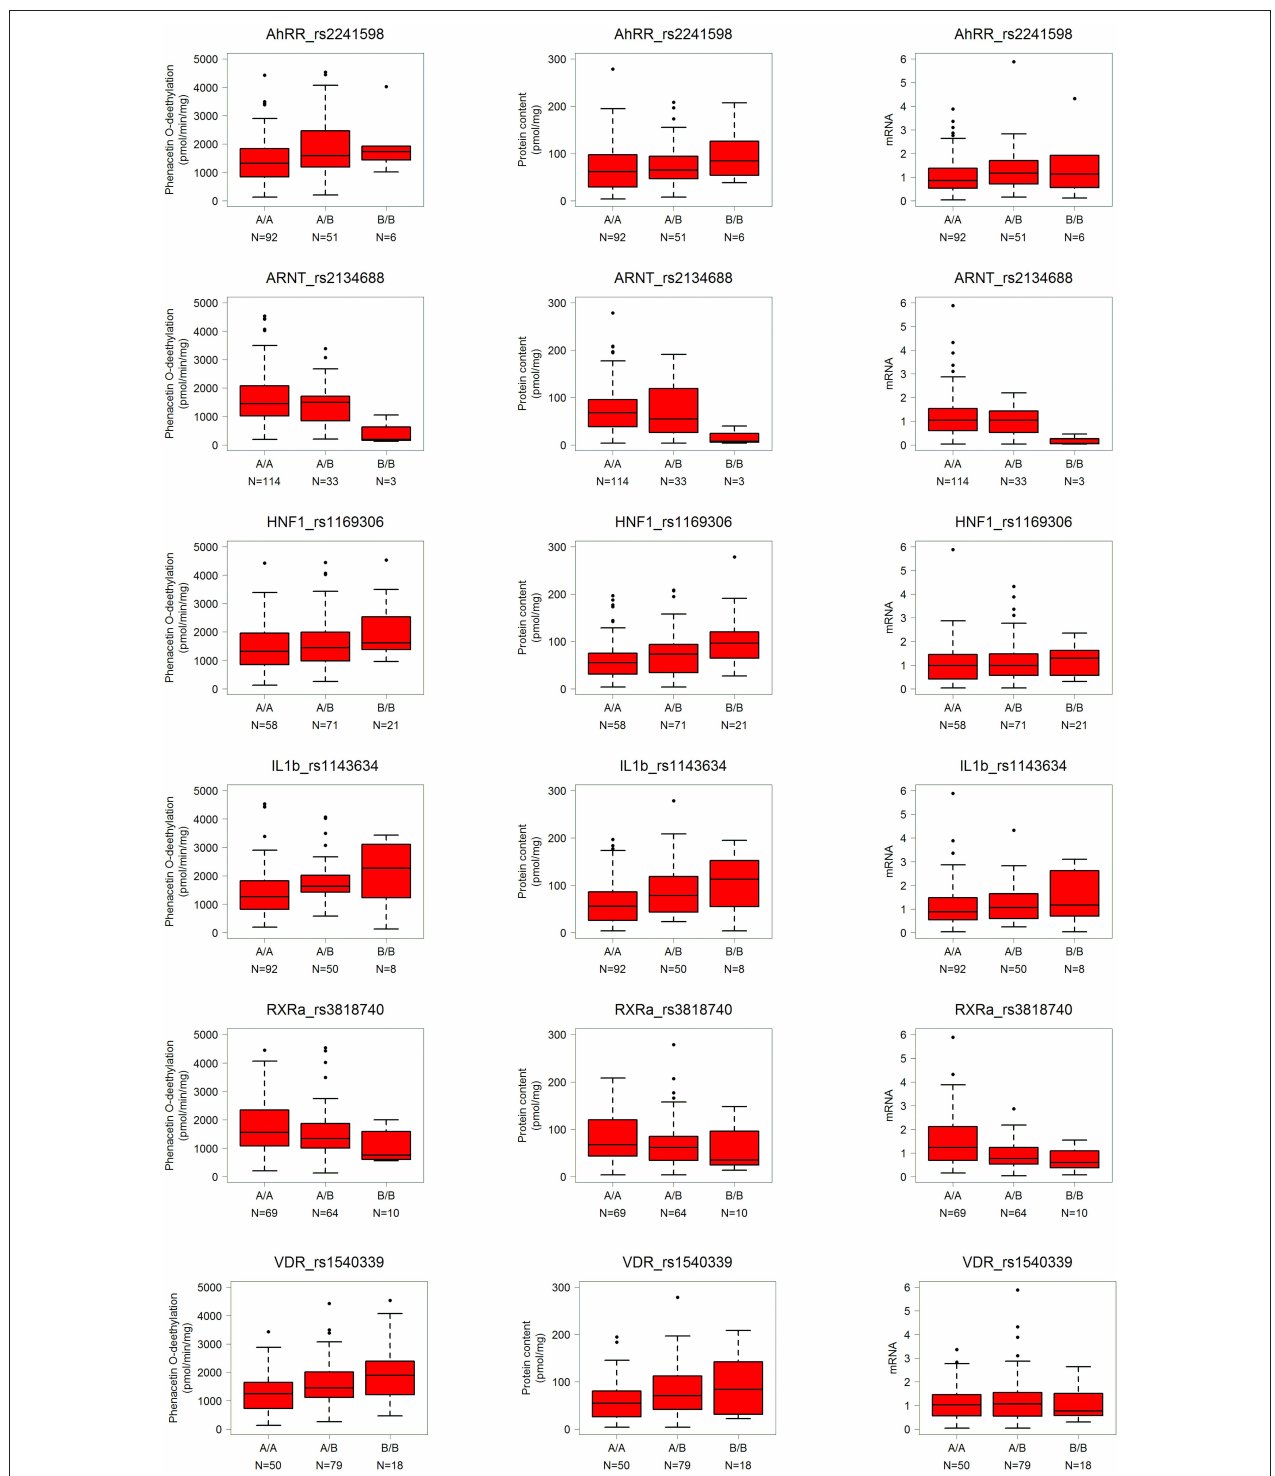
Figure 5 | genotype–phenotype correlations for CYP1A2 activity, protein, and mrNA exemplarily for some significant SNPs. Genotypes are indicated by A (major allele) and B (minor allele). N, number of individuals per group; numbers for the three genotypes do not add up to 150 in each case due to missing values. Selected representative results are shown as box-and-whisker plots with outliers for significant SNPs taken from Table 4